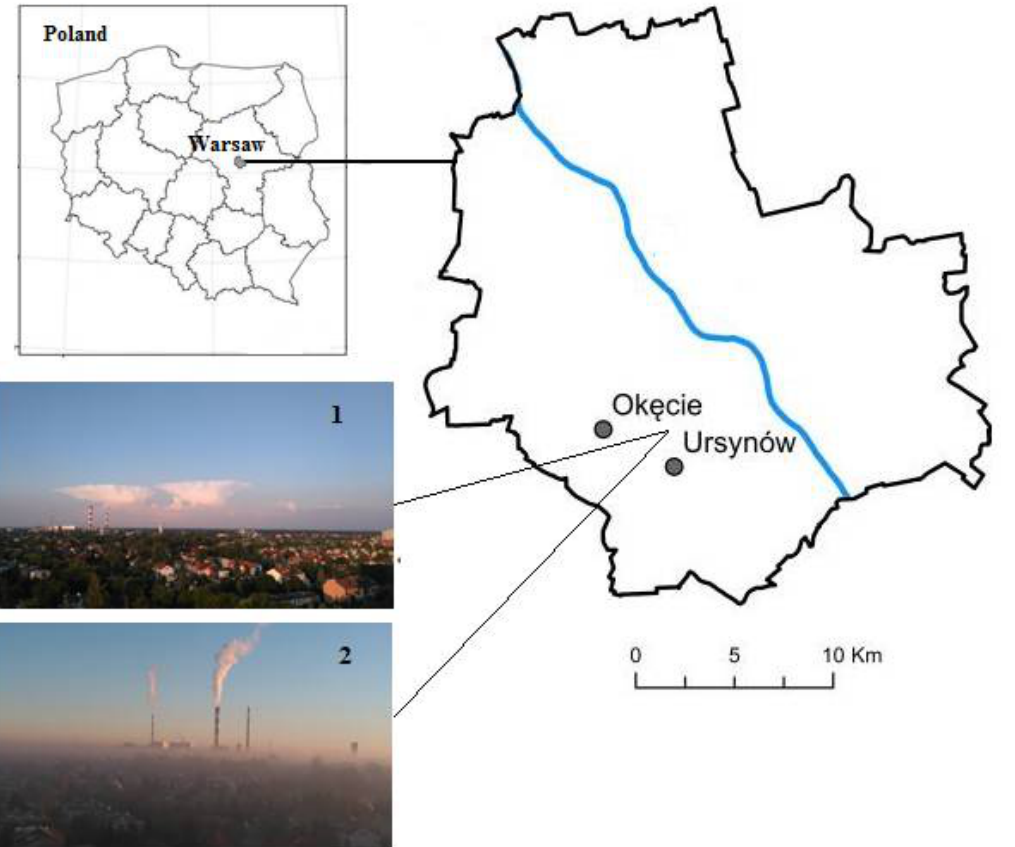
Figure 1. Location of the air quality, meteorological and visibility stations in the enlarged map of Warsaw with a map of Poland (Foto 1: Vis = 14 km; Foto 2: Vis = 3.7 km).